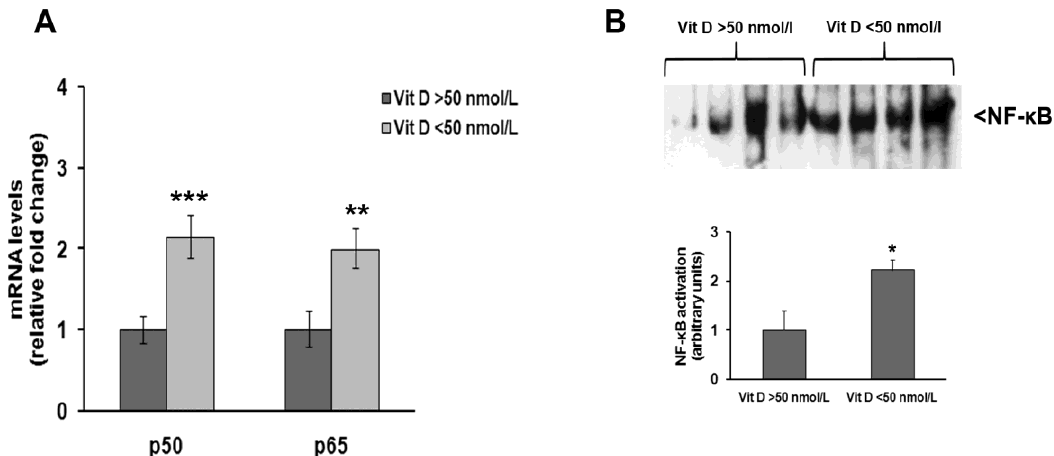
Figure 2. NF- κB expression and activation are increased in PBMC of vitamin D deficient individuals recruited for this study. ( A ) Quantitative Real-time PCR analysis of NF- κB p50 and p65 subunits mRNA levels after normalization against β -actin mRNA levels; ( B ) representative electrophoretic mobility shift assay (EMSA) pictures of active NF- κB nuclear protein levels and densitometric analysis of NF- κB bands. * p <0.05, ** p <0.01, *** p <0.001, significant differences in comparison to individuals having normal vitamin D levels.